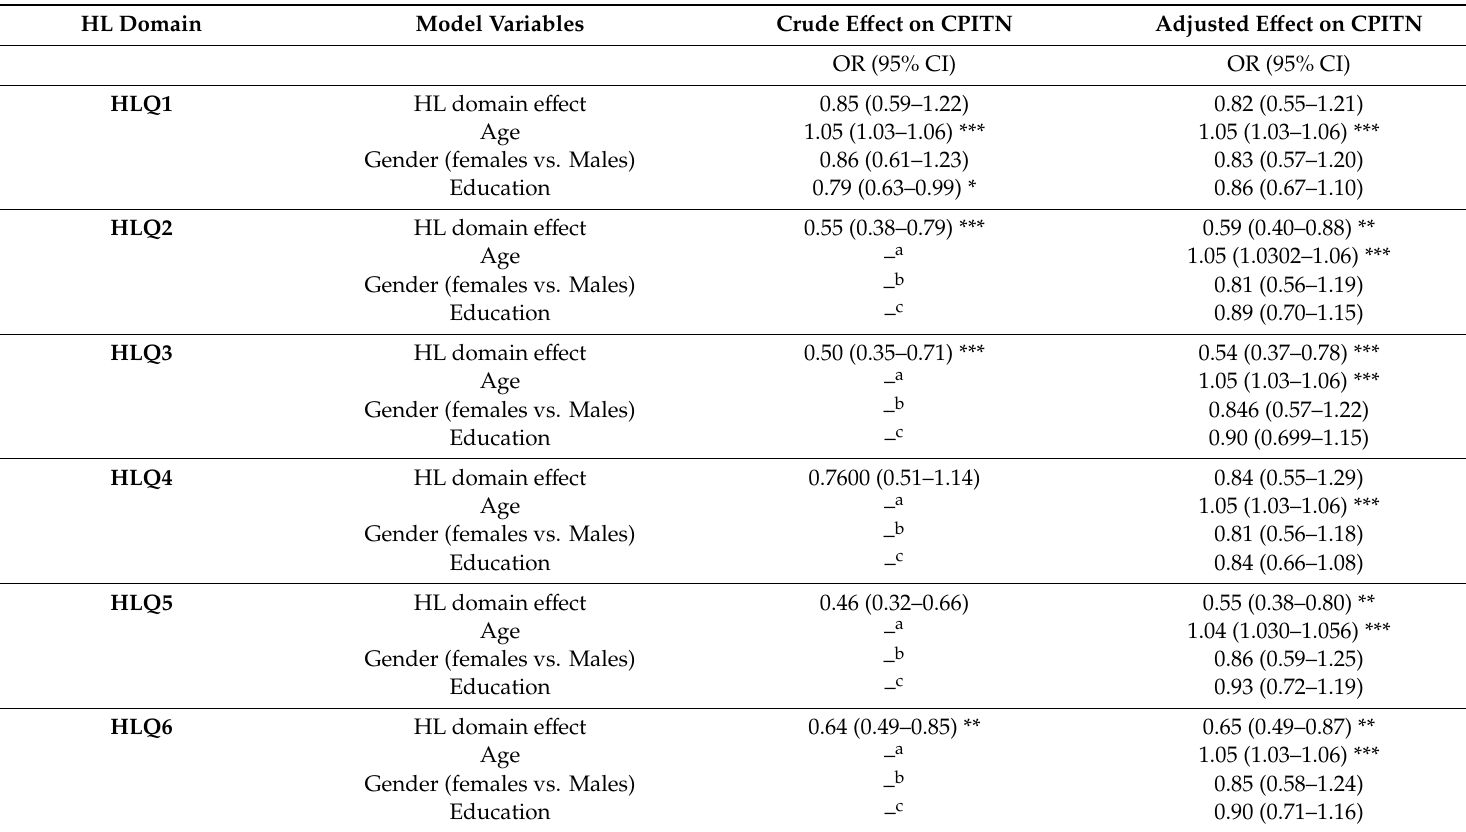
Table 4. Crude e ff ects (odd ratios (OR) and 95% confidence interval (95% C.I.)) of health literacy domains and sociodemographic variables on the presence of periodontal disease, and health literacy domain e ff ects on periodontal disease adjusted for sociodemographic